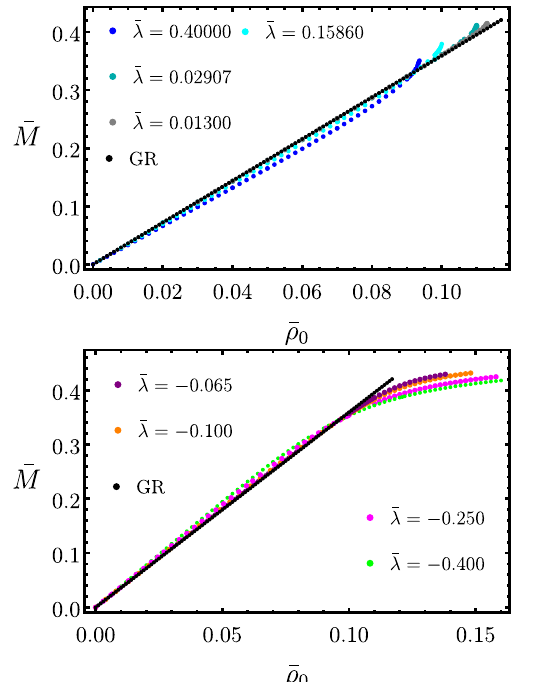
Fig. 5 ¯ M as a function of ¯ ρ 0 , for varios values of ¯ λ > 0 (upper panel) and ¯ λ < 0 (lower panel)